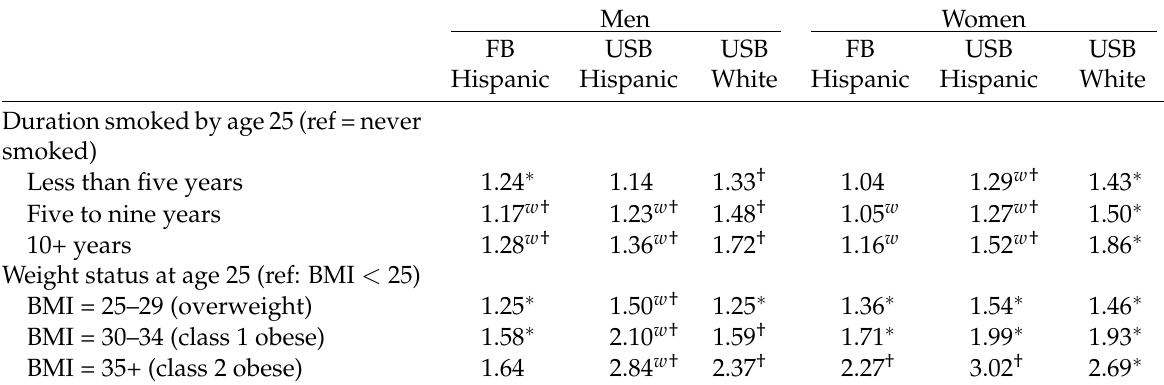
Table 2: Cox proportional hazards models predicting mortality (hazard ratios). Men Women FB USB USB FB USB USB Hispanic Hispanic White Hispanic Hispanic White Duration smoked by age 25 (ref = never smoked) Less than five